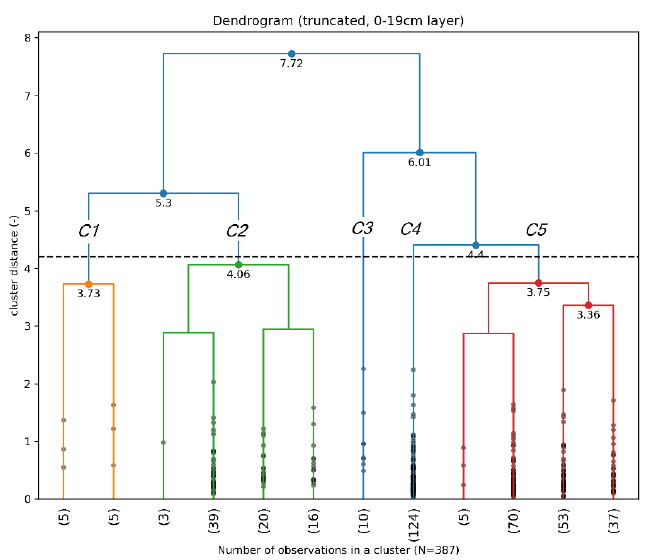
Figure 4. Clustering the data (0–19 cm layer) based on measured total porosity, field capacity and wilting point. The dendrogram shows groupings of the 387 samples starting from the root (bottom of y-axis). Based on interpretability and predictability (Figures 5 and 6), the data can be divided into five distinct classes (C1–C5). The classes at the opposite edges of the x-axis are the most dissimilar.